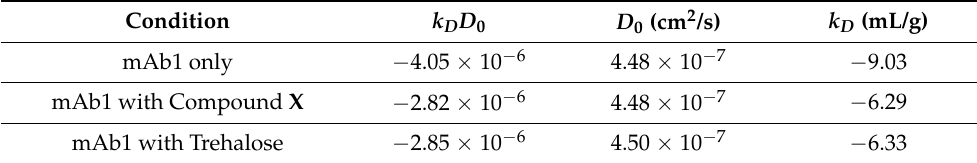
Table 3. k D values of all three formulations of mAb1 were negative suggesting net attractive interac- tions between antibody molecules in these formulations. Addition of either Compound X or trehalose made the k D values less negative, suggesting self-interactions of mAb1 reduce in prescience of these excipient molecules. Therefore, the propensity for antibody self-interaction decreases with the addi- tion of either Compound X or trehalose. Since the k D values are similar in mAb1 formulation with Compound X to those with trehalose, it is reasonable to suggest that Compound X is an aggregation breaker non-inferior to trehalose.